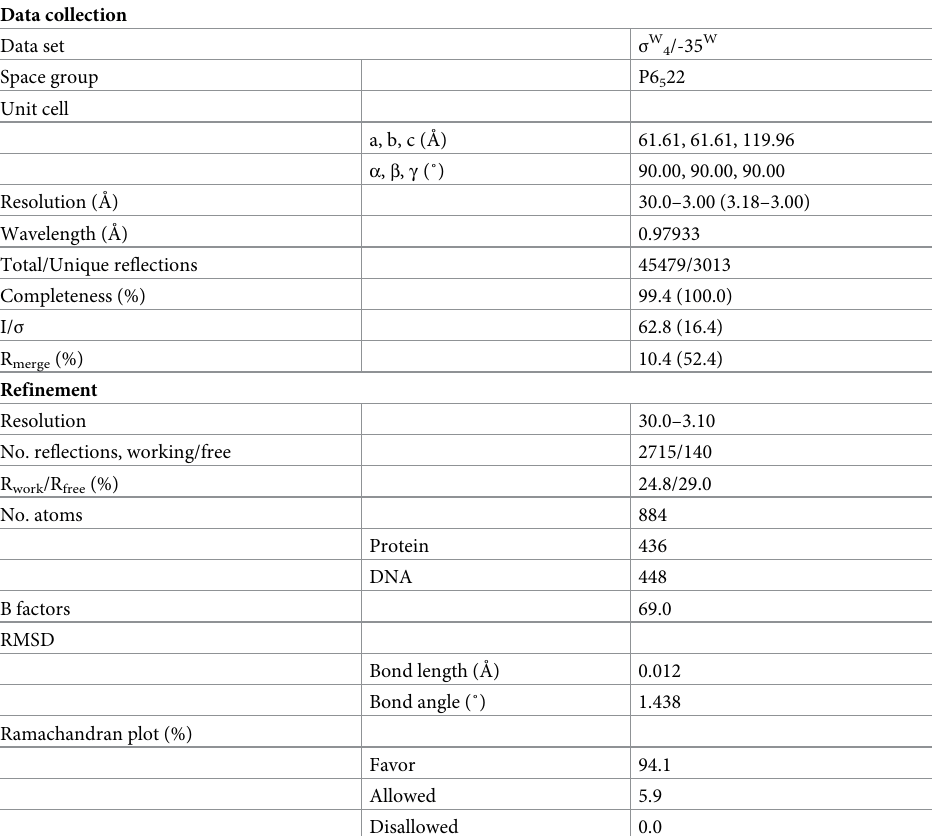
Table 1. Data collection and refinement